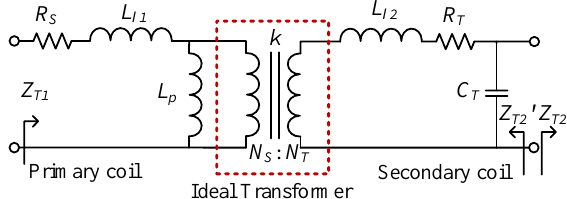
Figure 4. Equivalent circuit of a practical transformer.